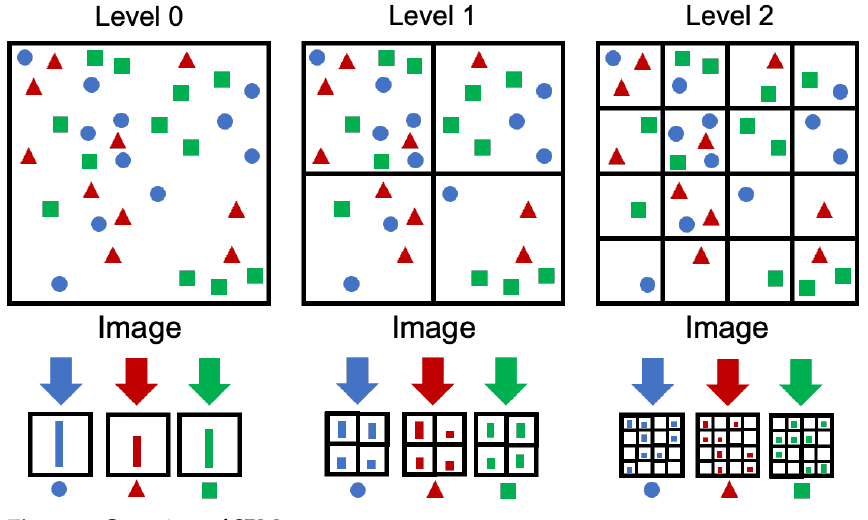
Figure 2. Overview of